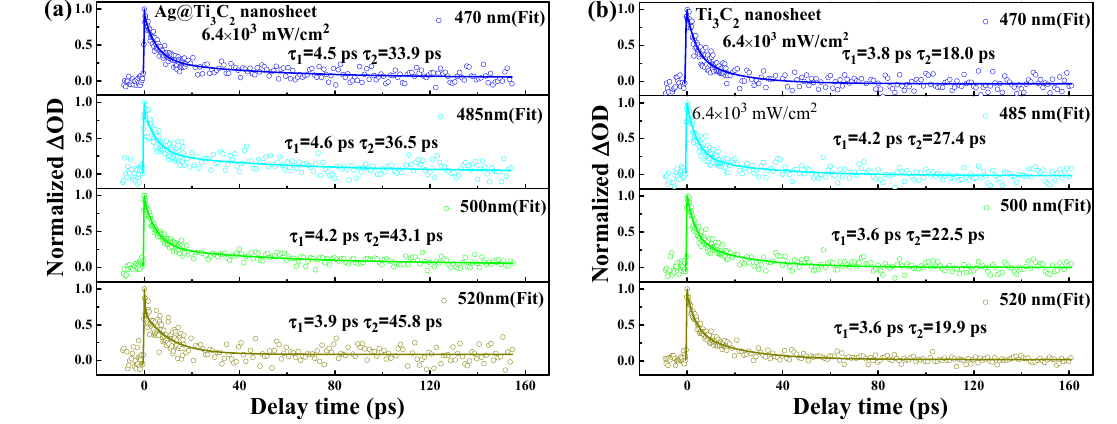
Figure 6. Carrier dynamics (at 400 nm pump) curves for ( a ) Ag@Ti 3 C 2 and ( b ) Ti 3 C 2 nanosheet at different probe wavelengths of 470, 485, 500, and 520 nm, respectively (the data points are experimental data while the solid lines are the curves of theoretical fits) with pump fluence fixed at 6.4 × 10 3 mW/cm 2 .